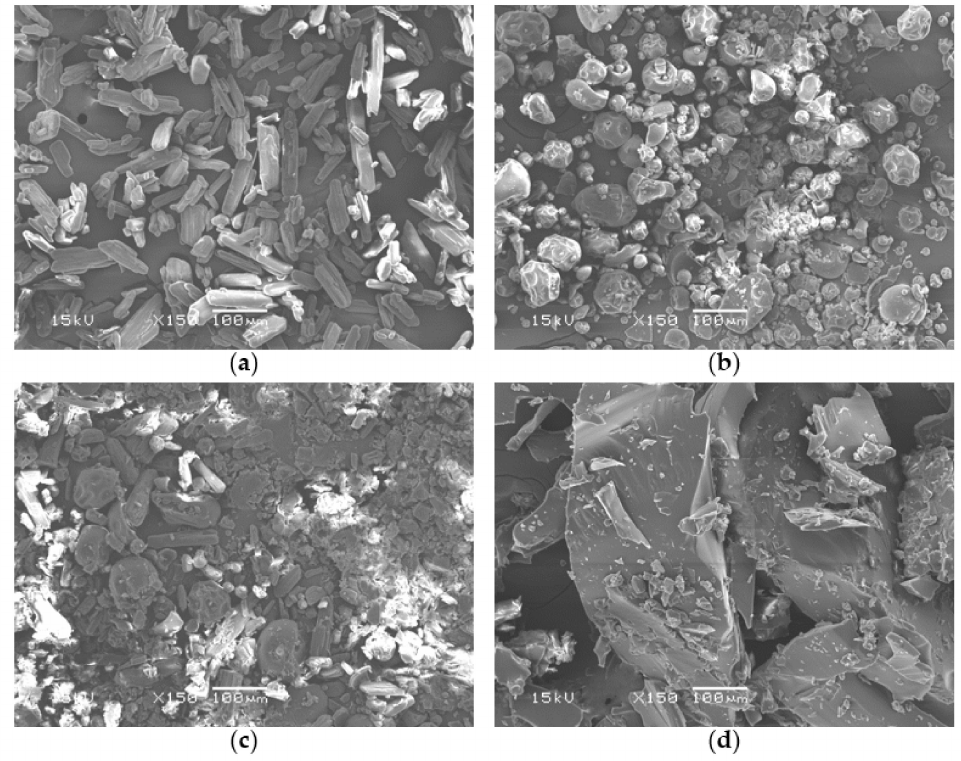
Figure 3. SEM images of ( a ) raw powder of ibuprofen, ( b ) PVP Kollidon 12 PF (PVP K12), ( c ) physical mixture, and ( d ) extrudate.